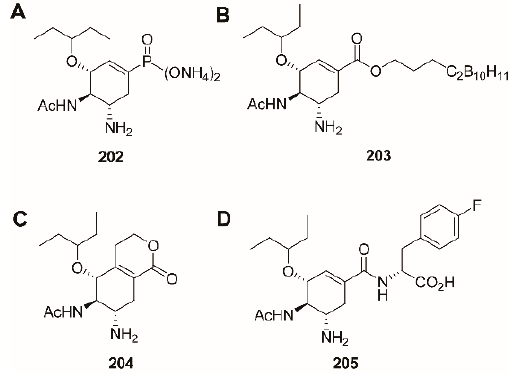
Figure 4. C-1 modified oseltamivir analogues. ( A ) Tamiphosphor ( 202 ) [108]; ( B ) Oseltamivir bearing a boron cluster reported by Lesnikowski and coworkers [124] ( 203 ); ( C ) A bicyclic derivative of oseltamivir synthesized by Kanai and Saito [125] ( 204 ); ( D ) A 4- F -phenylalanine ( R ) derived oseltamivir analogue ( 205 ).